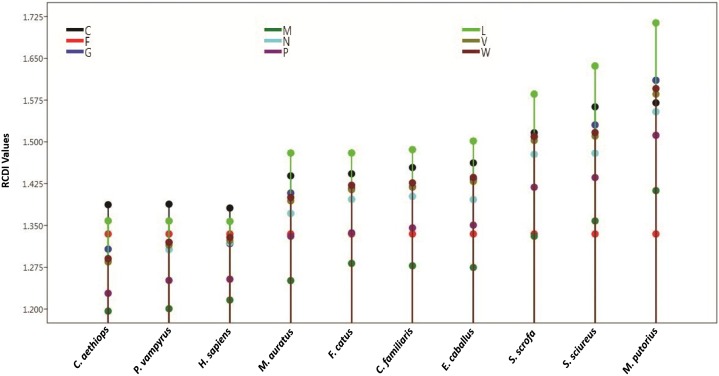
Tree plot for intragenic RCDI analysis. The plot indicates an average RCDI values with reference to different hosts and the 9 coding sequences of NiV. For adaptation of NiV genome, with least RCDI values African green monkey and with highest RCDI values Ferrets are best and least adapted, respectively, for growth NiV, where exhibiting the RCDI and hence east adapted. (For a single gene, an average RCDI has been taken).